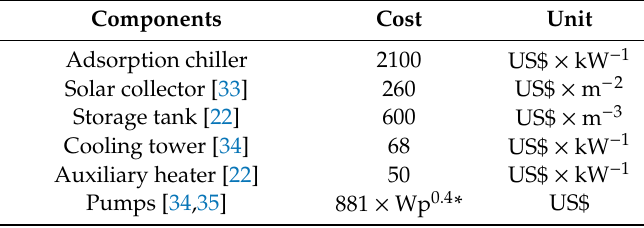
Table 2. The initial capital cost of the main equipment